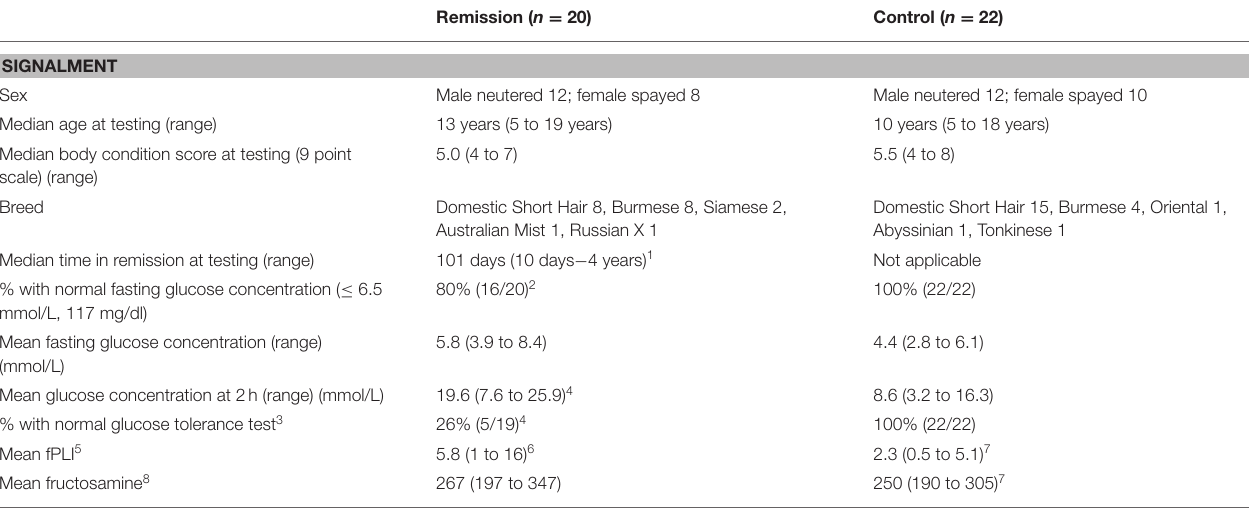
TABLE 1 | Signalment, body condition score, fasting and 2h glucose concentrations during a GTT for cats in diabetic remission and control cats.